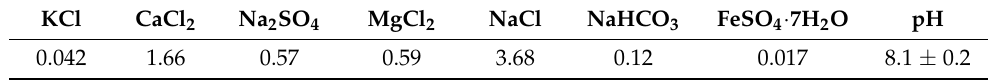
Table 1. Composition of artificial groundwater